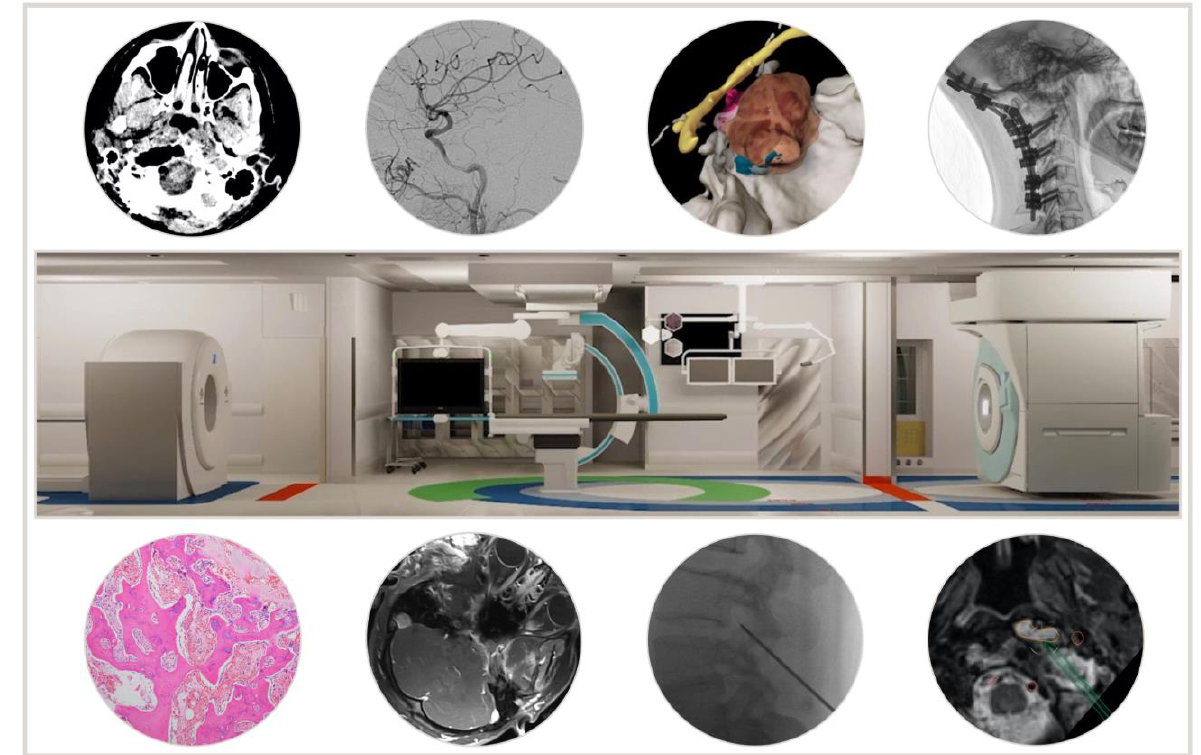
Figure 1. Advanced Multimodality Image-Guided Operating (AMIGO) suite and examples of the different modalities acquired and used in patients from this